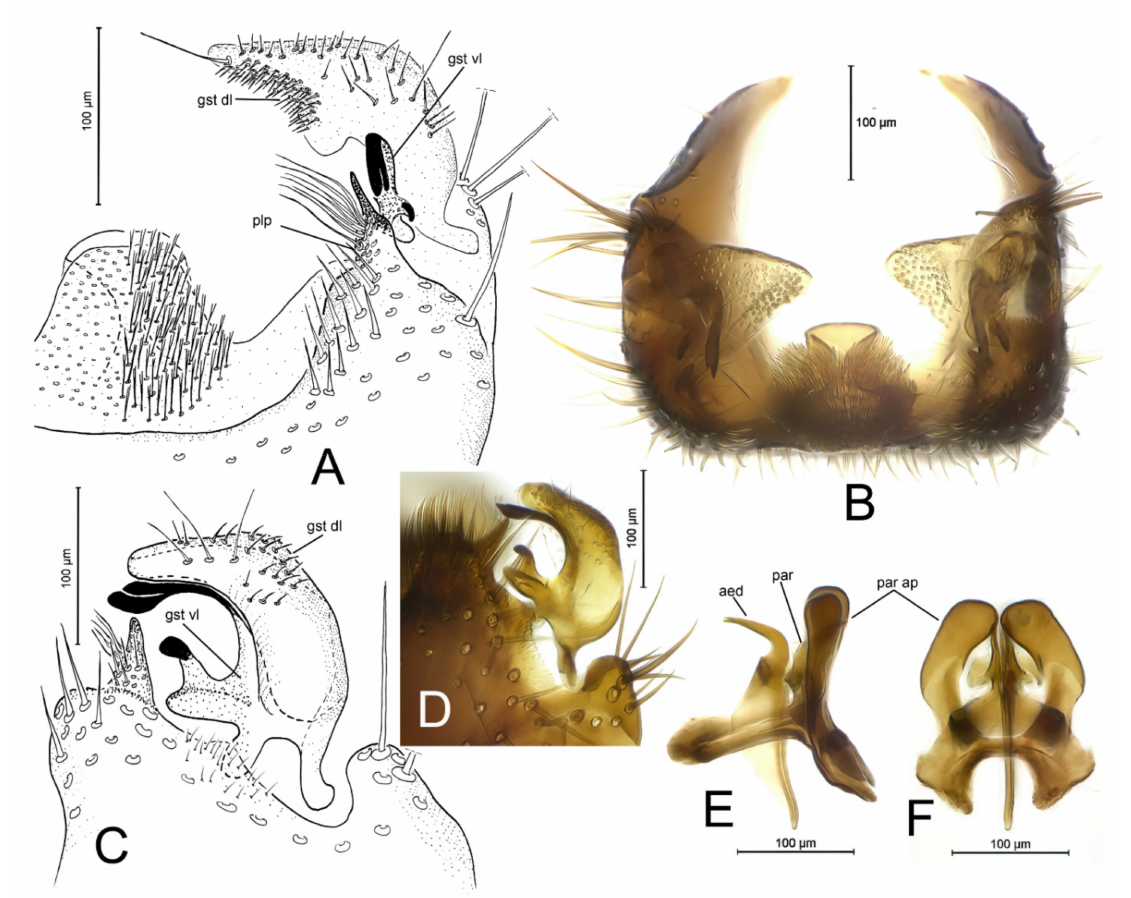
Figure 3. Docosia landrocki Laštovka and Ševˇc í k, 2006, (IZBE0222620), terminalia. ( A ) Postero-ventral view of gonostylus ♂ and gonocoxite; ( B ) Posterior view. ( C , D ) Lateral view of gonostylus. ( E ) Lateral view of aedeagal complex. ( F ) Ventral view of aedeagal complex. For abbreviations see Figure